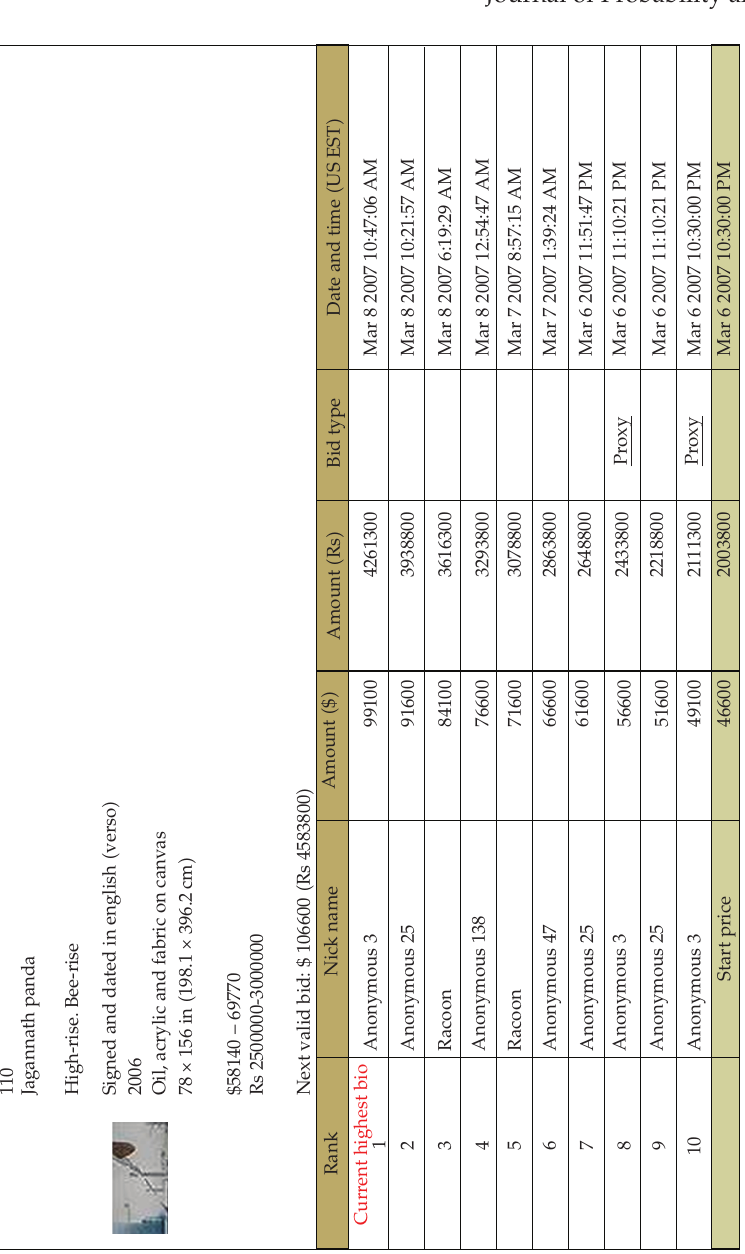
Figure 1: Bid History from an Online Auction of Modern Indian